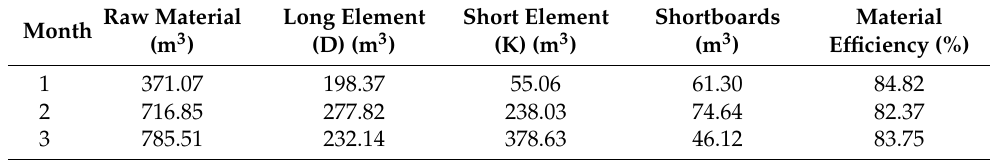
Table 8. The results of sawn timber prefabrication for furniture elements according to the variant “Cp”. Raw Material Month (m 3